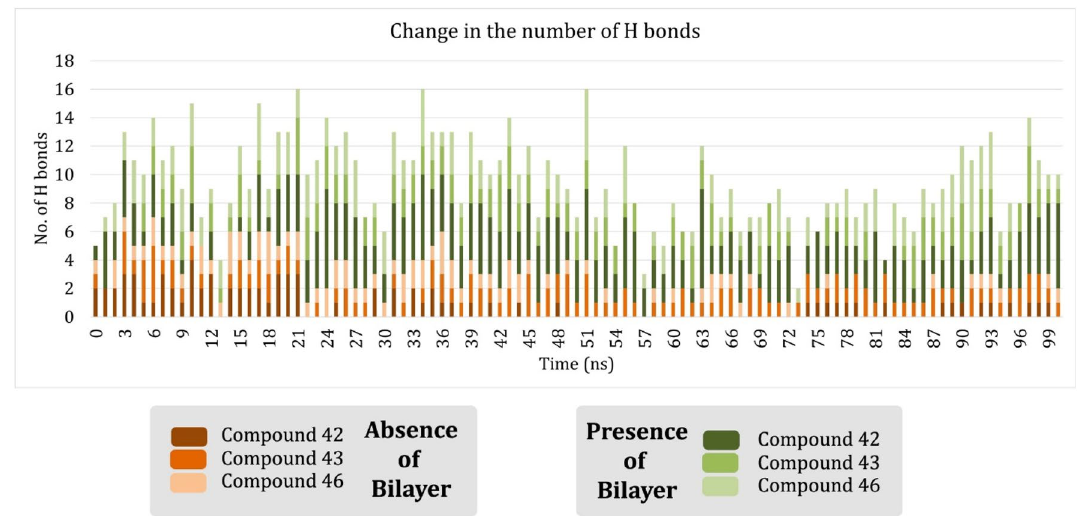
Figure 6. Number of Hydrogen bonds formed by SSTR2 ligands over time in presence and absence of the lipid bilayer. Number of H-bonds formed over time is notably more in the presence of lipids than in the absence of lipids.